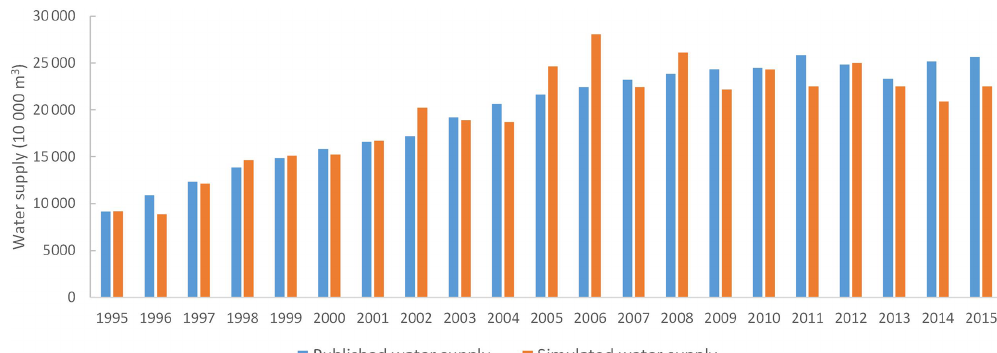
Figure 6. Comparison of water use between simulated and published